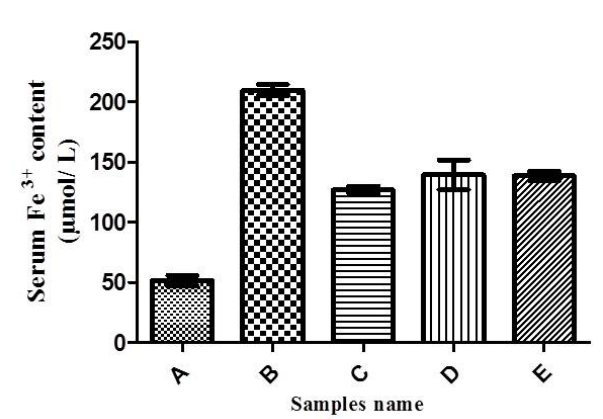
FIGURE 1 - The effect of iron chelators on serum Fe 3+ content. A: the control group, the mice receiving normal saline B: Iron-overloaded mice with no iron chelator, C: Iron- overloaded mice receiving DFO, D: iron overloaded mice receiving 30 mg/kg/day of naringin, and E: iron overloaded mice receiving 60 mg/kg/day naringin.